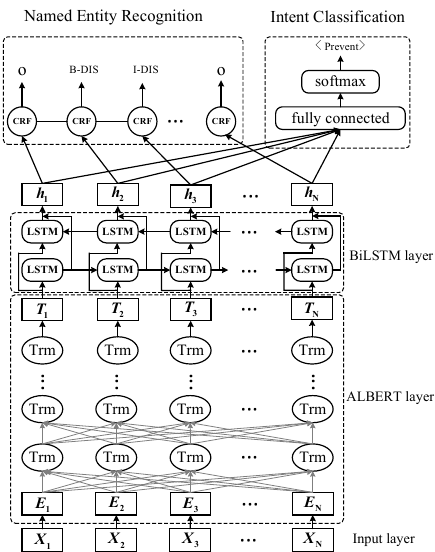
Figure 1. The architecture of MTL-ALBERT-BILSTM model.